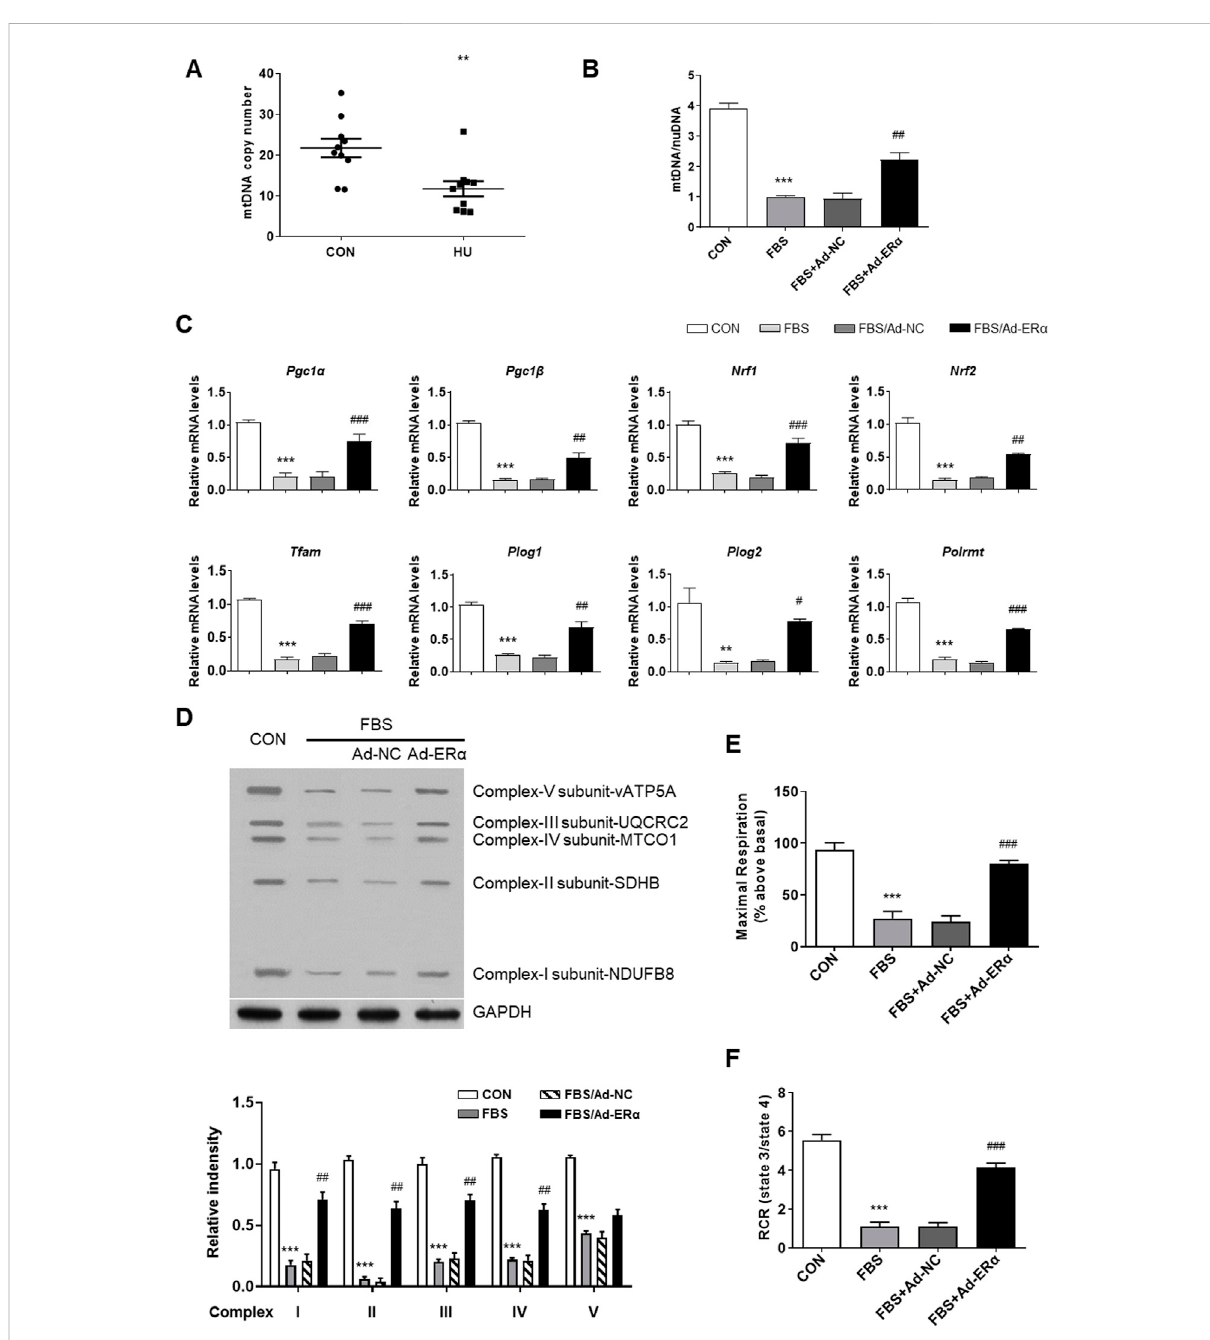
FIGURE 2 ER α increases mtDNA copy number and mitochondrial biogenesis. (A) The mtDNA copy number in cerebral VSMCs ( n = 10 per group). (B – F) The mtDNA copy number (B) , the mRNA expression levels of Pgc1 α , Pgc1 β , Nrf1, Nrf2, Tfam, Plog1, Plog2 , and Polrmt (C) , representative subunits of the electron transport chain (D) , the maximal cellular respiration (E) and mitochondrial respiratory reserve capacity (F) in A7r5 cells treated with FBS after transfected with Ad-ER α or Ad-NC ( n = 3 per group). The A7r5 cells mentioned above were incubated with FBS for 72 h after transfected with adenoviruses expressing ER α or noncoding control for 48 h. * p < 0.05, ** p < 0.01 and *** p < 0.001 vs. control; # p < 0.05, ## p < 0.01 and ### p < 0.001 vs.